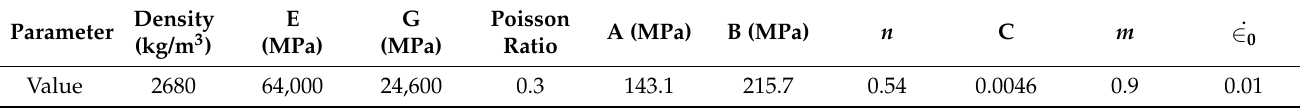
Table 1. Johnson–Cook model parameters for AA5052 for plasticity.